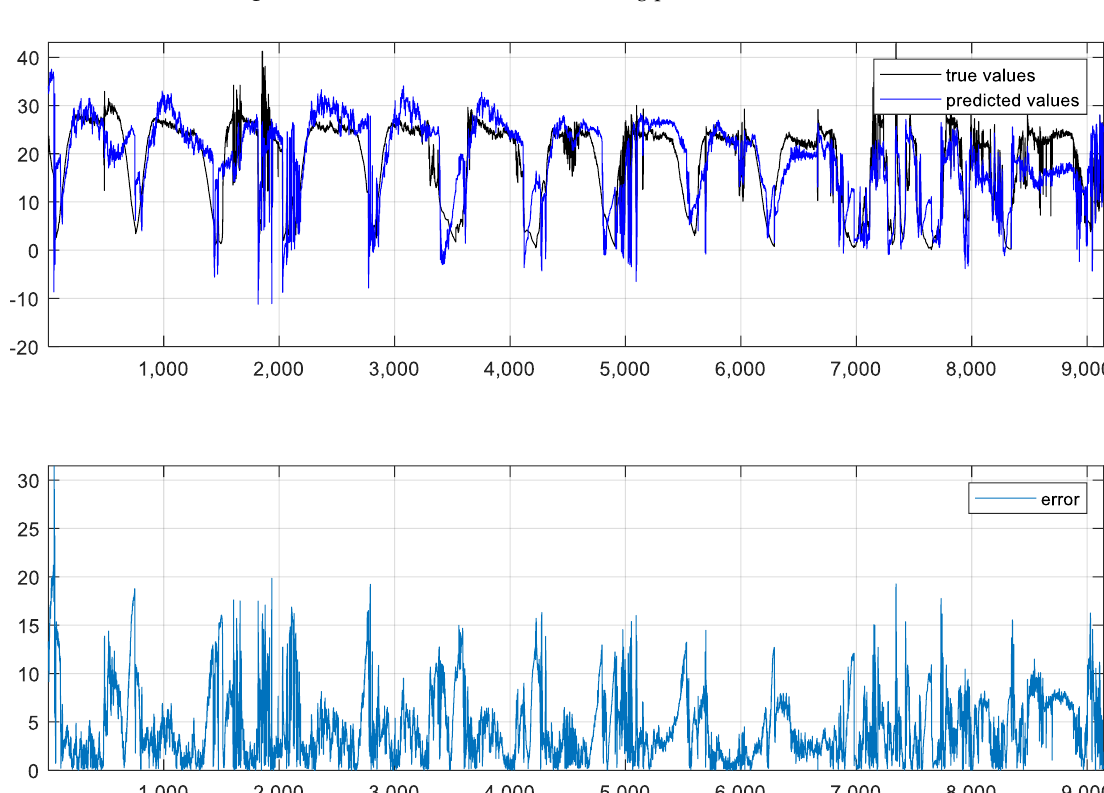
Figure 10. Results of ABC–ANN for training part.